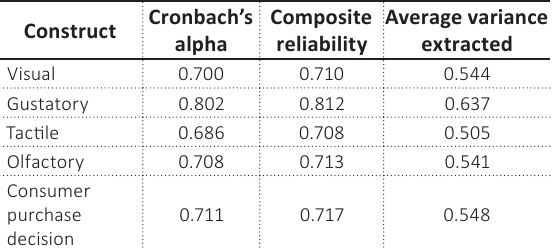
Table 1. Reliability and validity of the